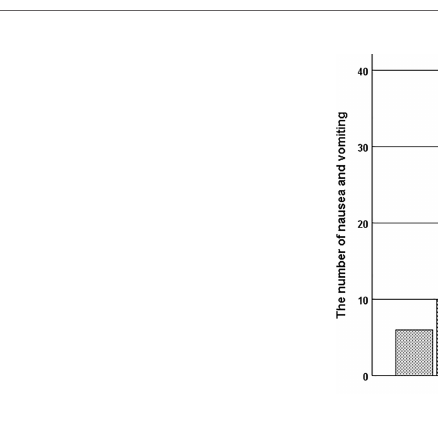
FIGURE 2 | The number of nausea and vomiting in acupuncture group and